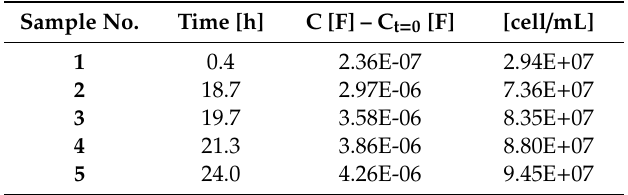
Table 2. Calculated cell numbers based on calibration in Figure 4b.